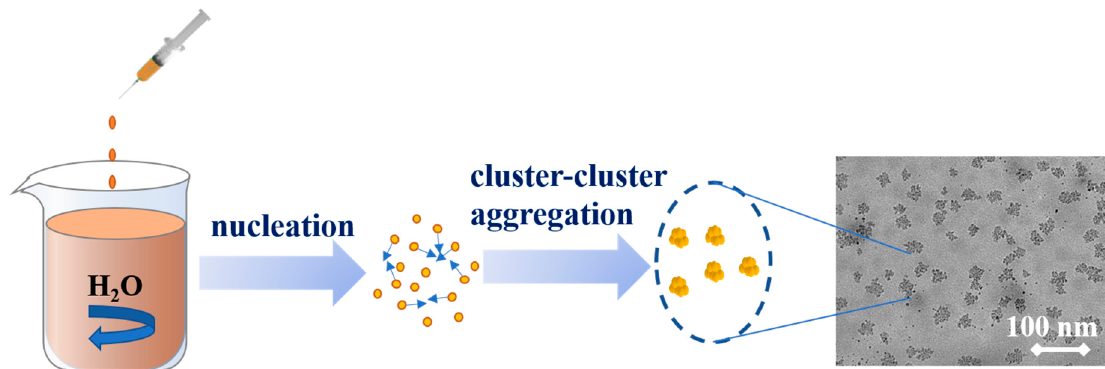
Figure 8. LNPs’ formation mechanism during dropping